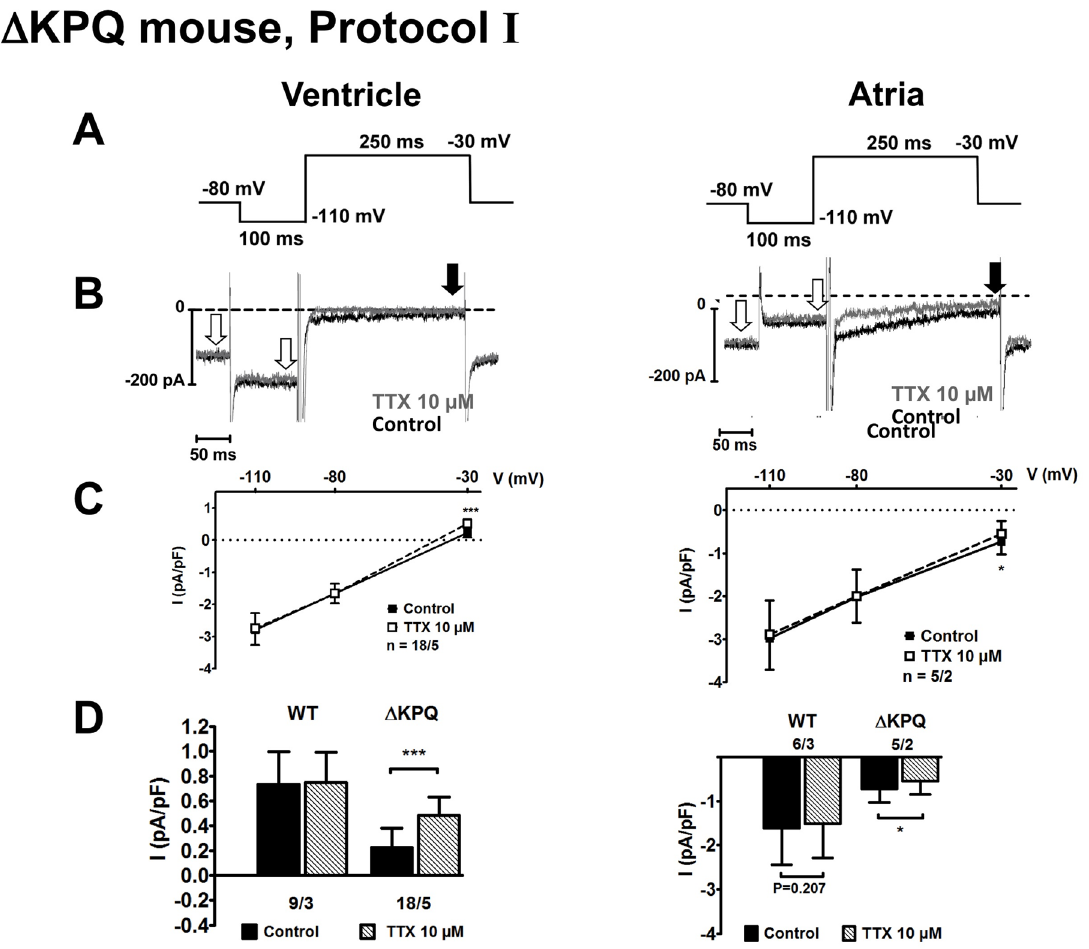
Fig 1. Effects of tetrodotoxin on I Na,late in ventricular and atrial cardiomyocytes (CM) from Δ KPQ-SCN5A mice. A and B : Voltage clamp protocol Ⅰ and examples of original current tracings recorded in Δ KPQ mouse myocytes under control conditions or in the presence of 10 μ M tetrodotoxin (TTX). Late sodium currents were measured at the end of the 250 ms-long pulse at -30 mV (black arrow). As internal control, current amplitude was also measured at -80 mV and -110 mV (white arrows). C : Current densities were plotted for each voltage without (control, black circles) and after addition of 10 μ M TTX (open squares). D : Currents measured at -30 mV before (black columns) and after TTX exposure (grey columns) in myocytes from wild type (WT) and Δ KPQ mice. Numbers below the columns (x/y) indicate number of cells per number of animals. TTX-sensitive current expressed as current density (in pA/pF). ** P < 0.01; *** P < 0.001; paired Student ’ s